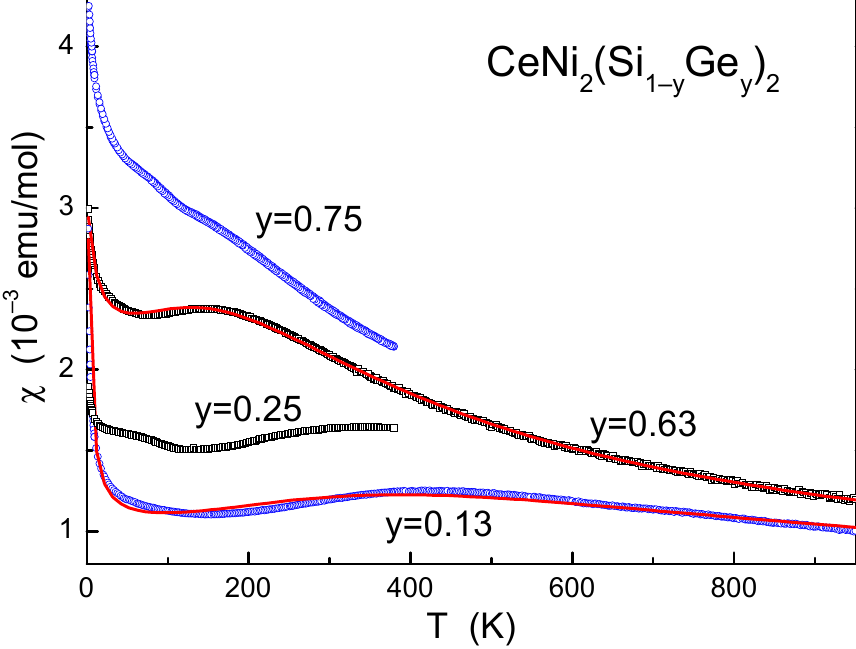
Figure 1. Magnetic susceptibility of CeNi 2 (Si 1 − y Ge y ) 2 . The ICF model is applied for y = 0.13 and 0.63 (measured up to 1000 K), Equation (2).